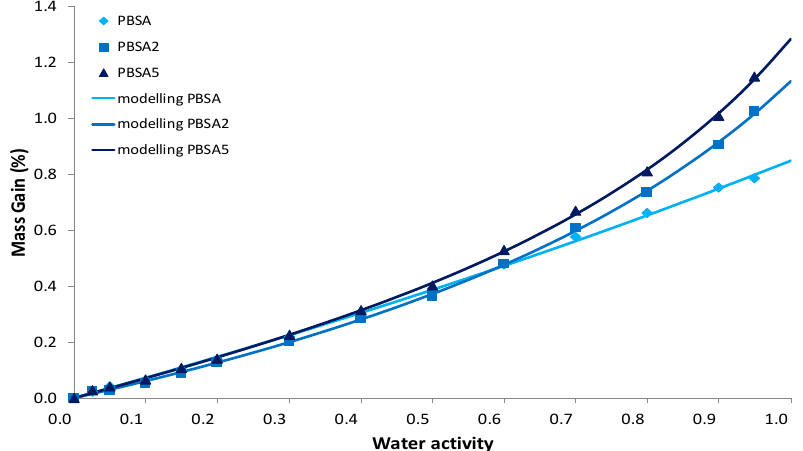
Figure 5. Water permeation curves for the neat PBSA and the filled PBSA films fitted using a model combining two sorption modes, the Henry-law sorption and the aggregation (clustering) sorption, as represented in Equation